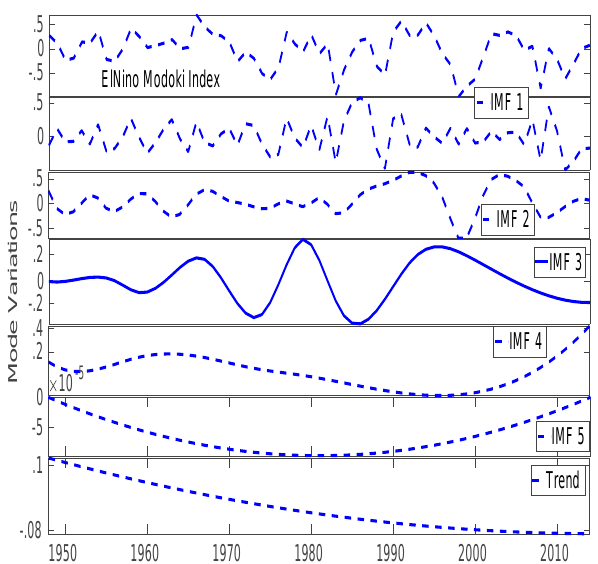
Figure 4. The EMD analysis of the TCPI signal in the North Indian Ocean. TCPI used here is derived using Dataset-3. The derived signal is shown in the first panel and its trend in the seventh panel. The third mode (IMF 3) retained for further analysis is shown in bold.